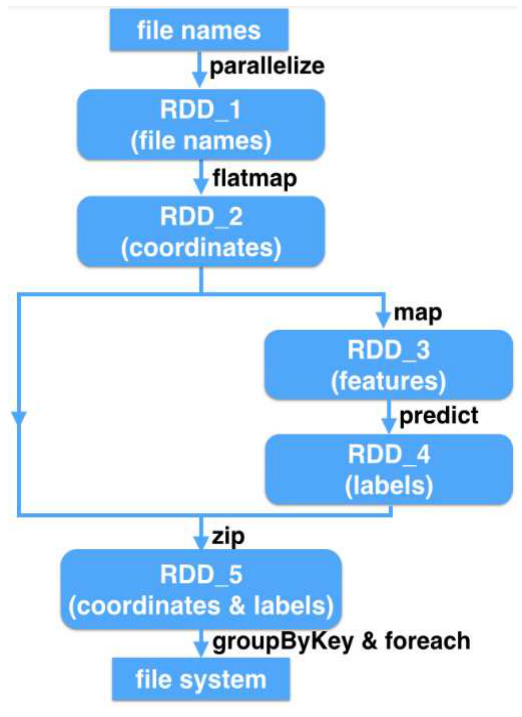
Figure 2. Spark processing